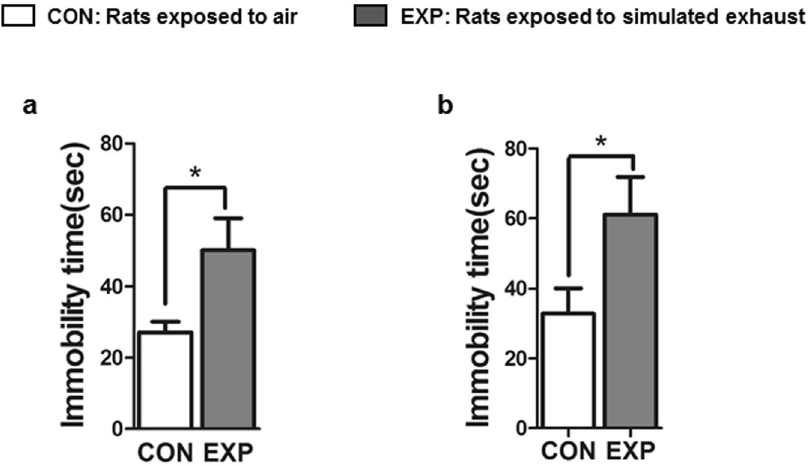
Figure 4. Examination of depression-like behavior ( a , b ) in rats subjected to high dose brief ( a , n = 9 rats/ group) and low dose prolonged ( b , n = 13 rats/group) 2 week SVEE. Depression-like behavior was examined using forced swim test. ( * ) Significantly different from control p < 0.05. Bars represent means ±